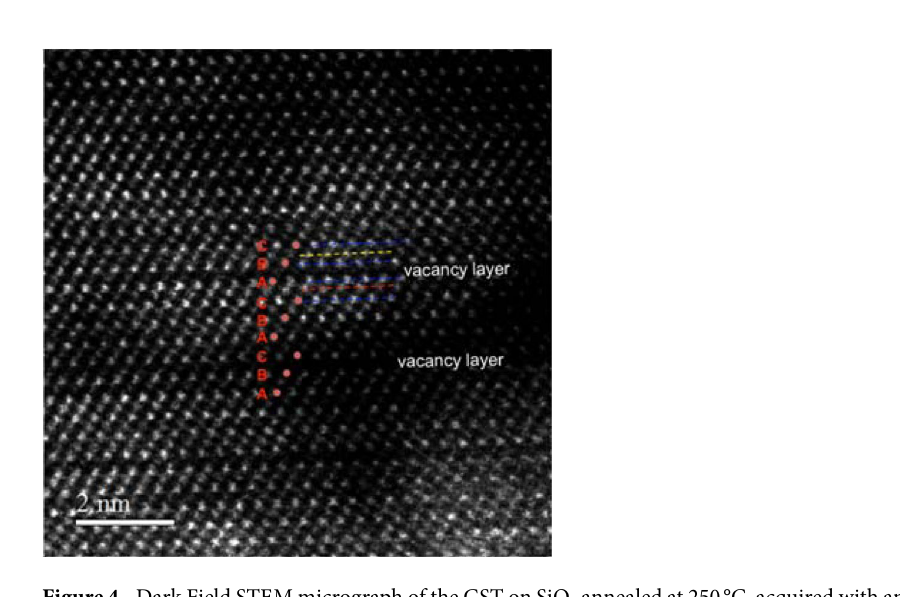
Figure 4. Dark Field STEM micrograph of the GST on SiO 2 annealed at 250 °C, acquired with an inner detector semiangle of 42 mrad. The stacking is that of the rocksalt phase, with ordered vacancy layers, as shown by the red spots. The distance between Te layers close to the vacancy layer (blue dashed lines) and the first cation plane is lowered only in some cases (red dashed